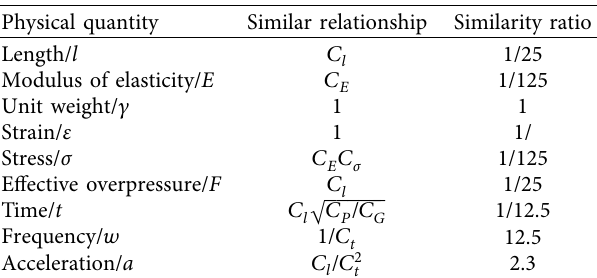
Figure 5: Shaking-table testing system. Table 3: Similarity relationship and similarity ratio of each physical quantity of the